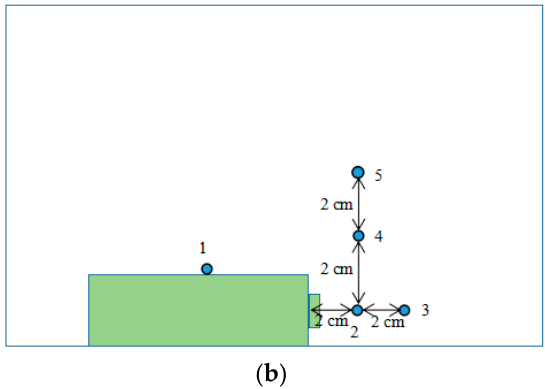
Figure 2. ( a ) Schematic of experimental setup; ( b ) the thermocouples setup around the battery (TC1 was used to detect the battery surface temperature; TC2, 3, 4, 5 were used to detect the flame temperature).